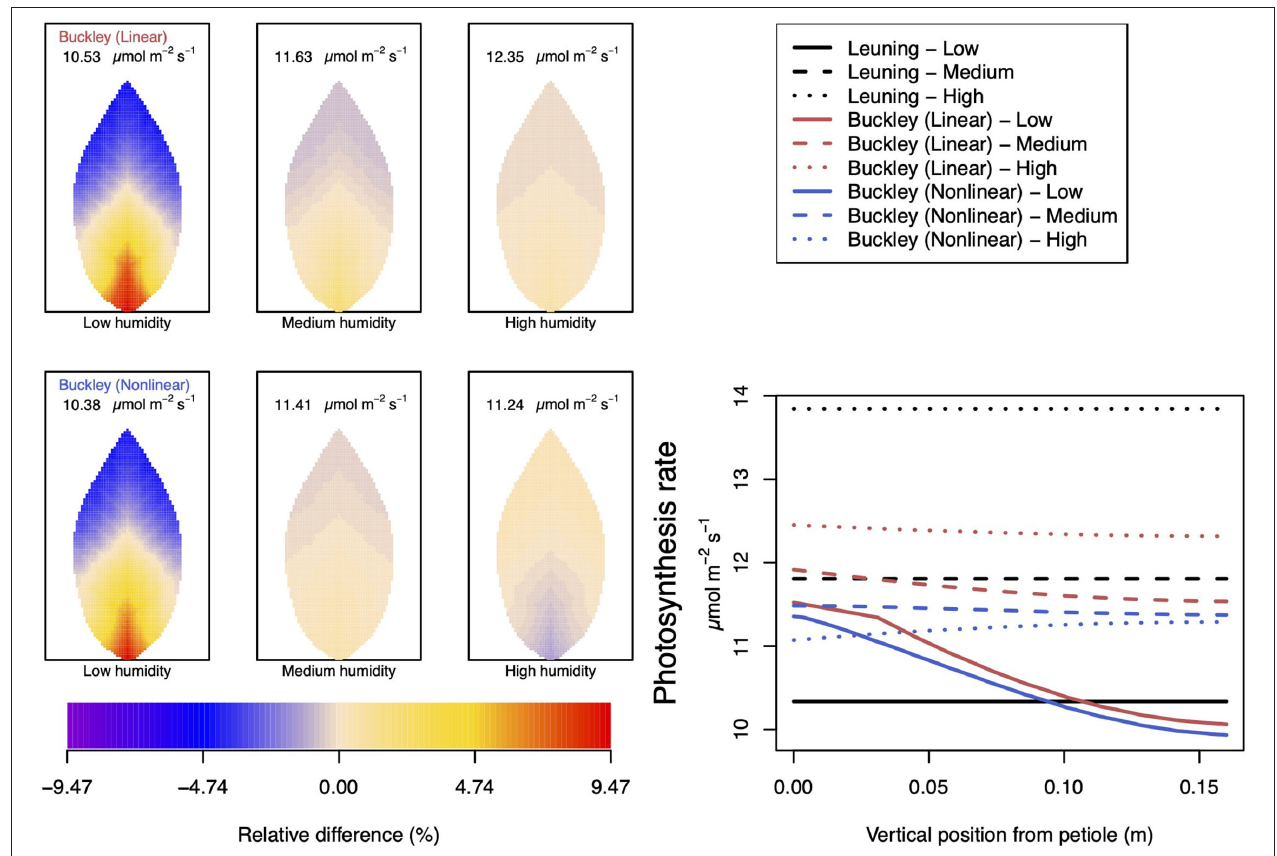
FIGURE 7 | A comparison of predictions of photosynthetic activity distributed over the leaf according to the three stomatal conductance models of Leuning (1995) (black lines in right hand figure), linear (Buckley et al., 2003) (top row of panels and red lines in the right hand figure), and nonlinear (Buckley et al., 2003) (bottom row of panels and blue lines in right hand figure). The 2D maps shown are deviations from leaf-area averages. The leaf-area average values of photosynthesis rates are given at the top of each panel. The three columns (left-to-right) and line styles (solid, dashed, dotted) show the respective dependencies on the atmospheric relative humidity : low (10%), medium (50%), and high humidity (90%). For the Leuning (1995) model, the uniform predictions equal the leaf-area photosynthesis averages of 10.34, 11.81, and 13.84 µ mol m − 2 s − 1 under low, medium, and high humidity, respectively (2D heat maps are not shown). Other model parameter values can be found in Supplementary Information I